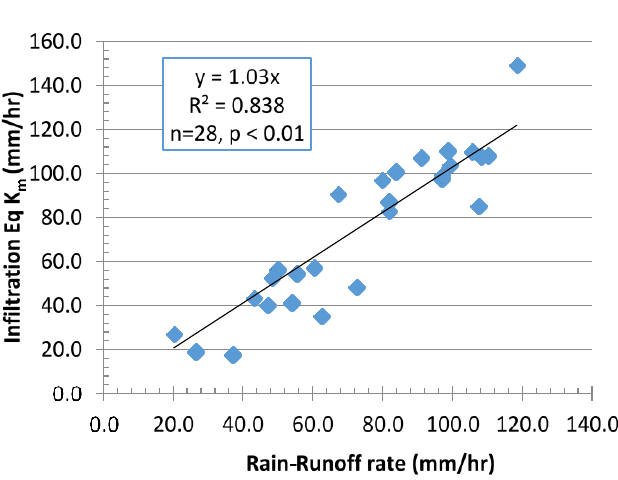
Figure 4. Dependence of Infiltration Equation K m values on Rain–Runoff rates for granitic soil RS plots having runoff.